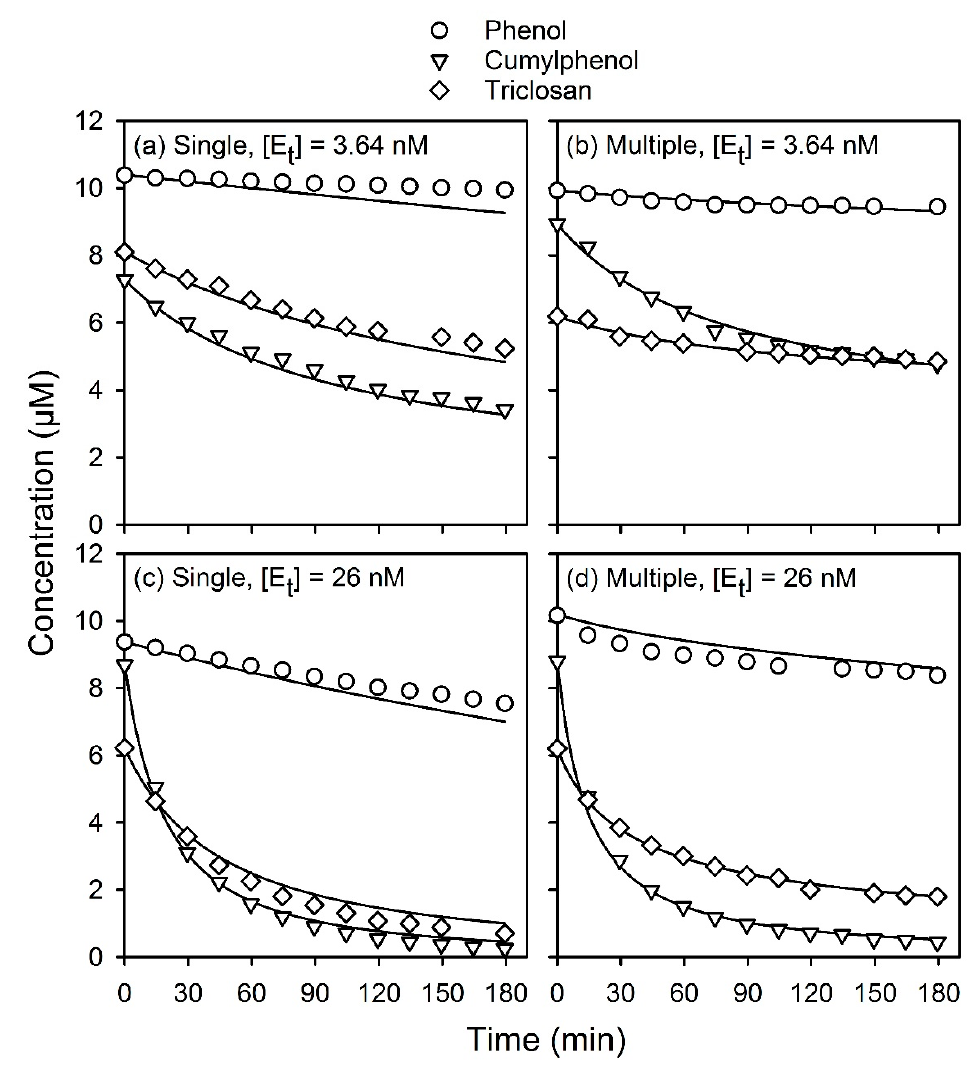
Figure 6. Experimental measurements (symbols) and model predictions (lines) for the laccase-catalyzed oxidation of phenol, cumylphenol, and triclosan: ( a ) oxidation of individual substrates using 3.64 nM laccase; ( b ) oxidation of a mixture of all three substrates using 3.64 nM laccase; ( c ) oxidation of individual substrates using 26 nM laccase; ( d ) oxidation of a mixture of all three substrates using 26 nM laccase.